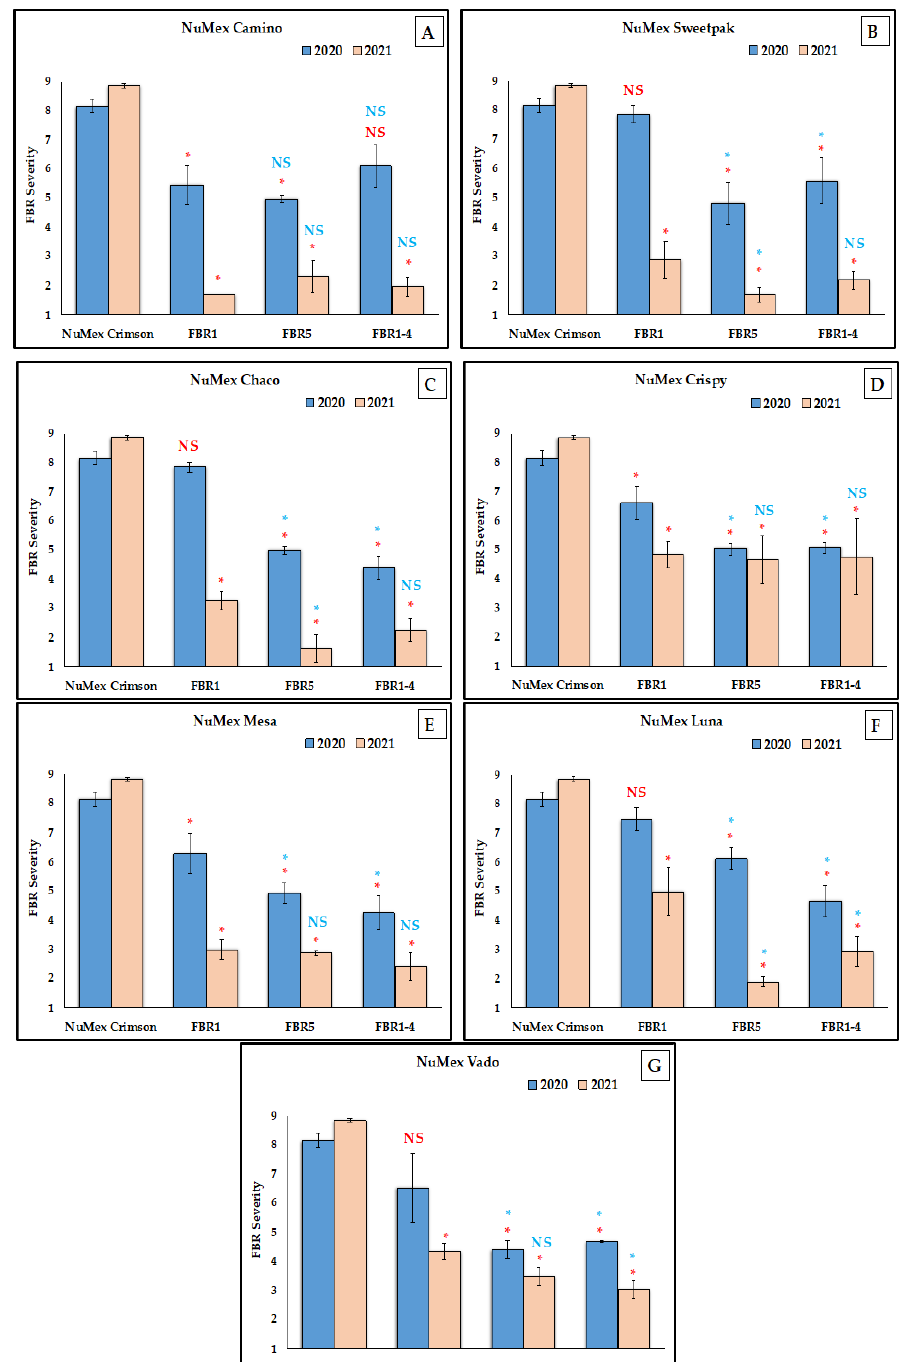
Figure 3. FBR severity of check cultivars in 2020 and 2021, where ‘NuMex Crimson’ is the suscepti- ble check, and ‘Serrana’ is the partially resistant check. Error bars are the standard errors of the mean for FBR severity. * refers to means different from ‘NuMex Crimson’ at p < 0.05.